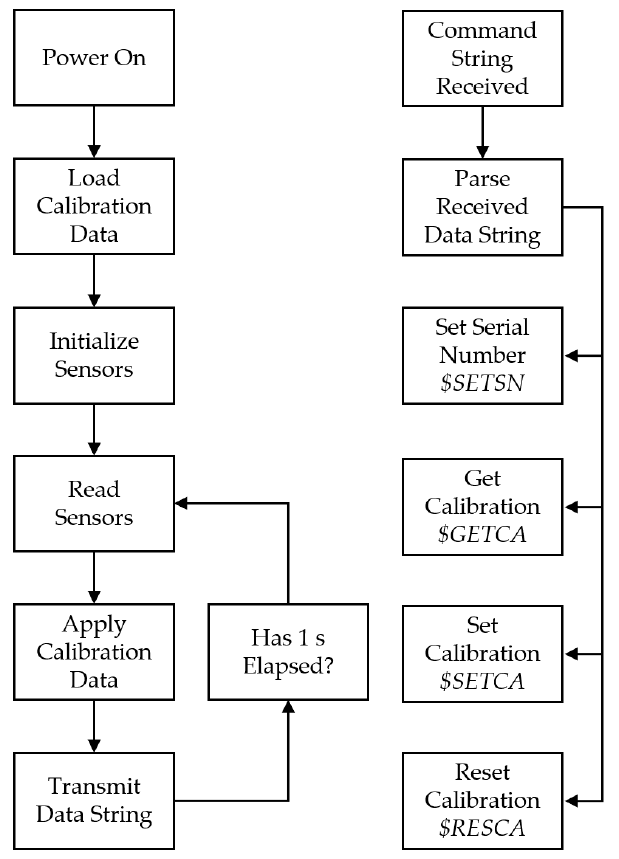
Figure 2. Block diagram of the PTH probe microcontroller firmware generalizing functionality. The main thread handled sensor measurements, data processing, and data transmission. An interrupt service routine handled serial data input from a host device for setting the serial number, retrieving existing calibration data, setting the calibration data to specific values, and resetting the calibration data to factory defaults.